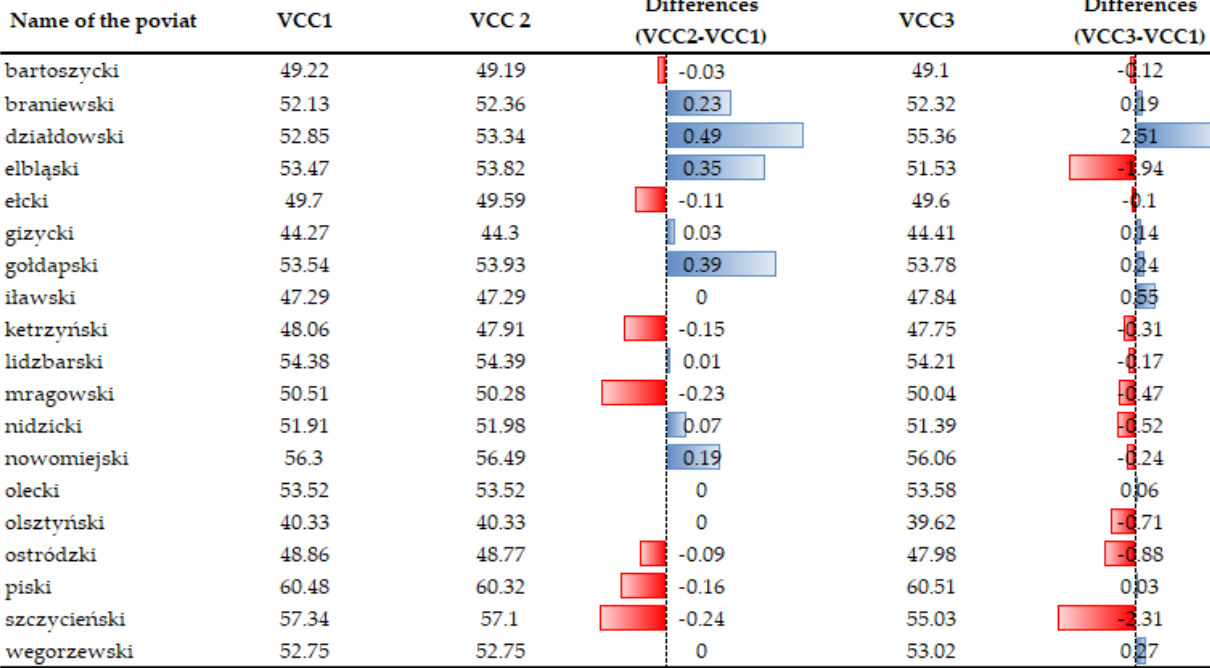
Figure 14. Sensitivity analysis for vulnerability to climate change (VCC1, VCC2, VCC3) taking into account various solution variants. Source: own study.